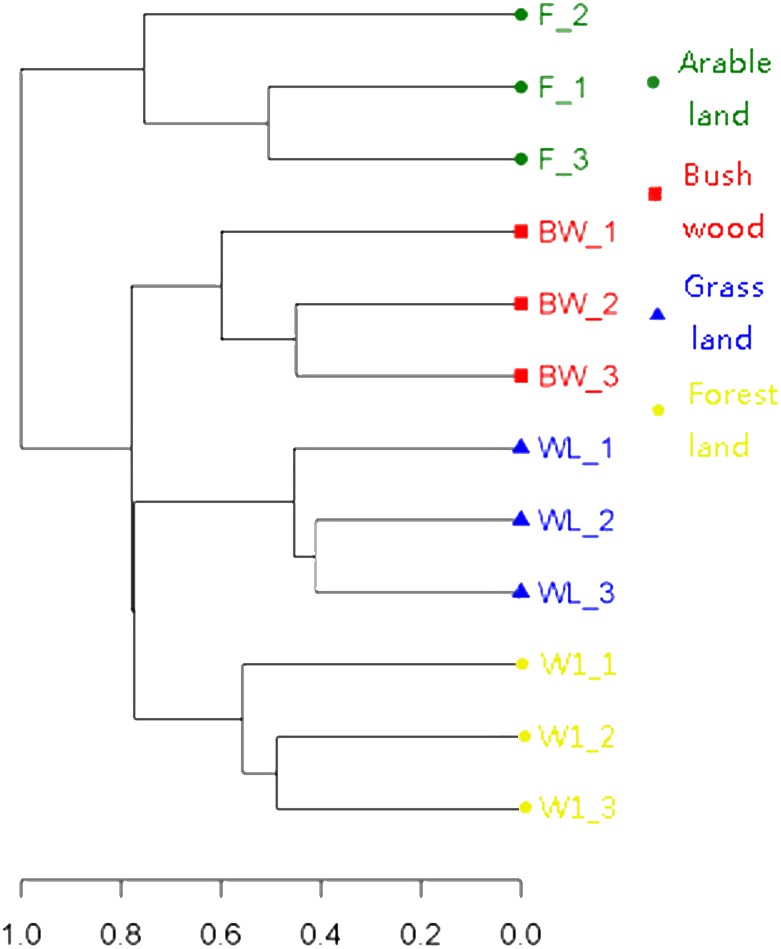
Clustering analysis of AMF communities based on OTU abundance for each soil.